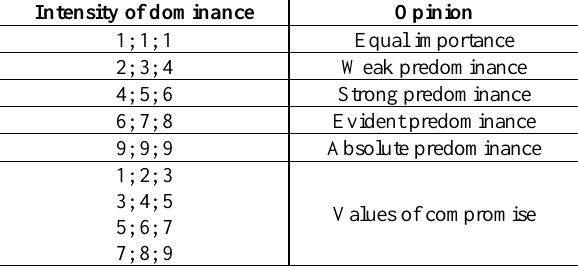
Table 1. Saaty’s scale